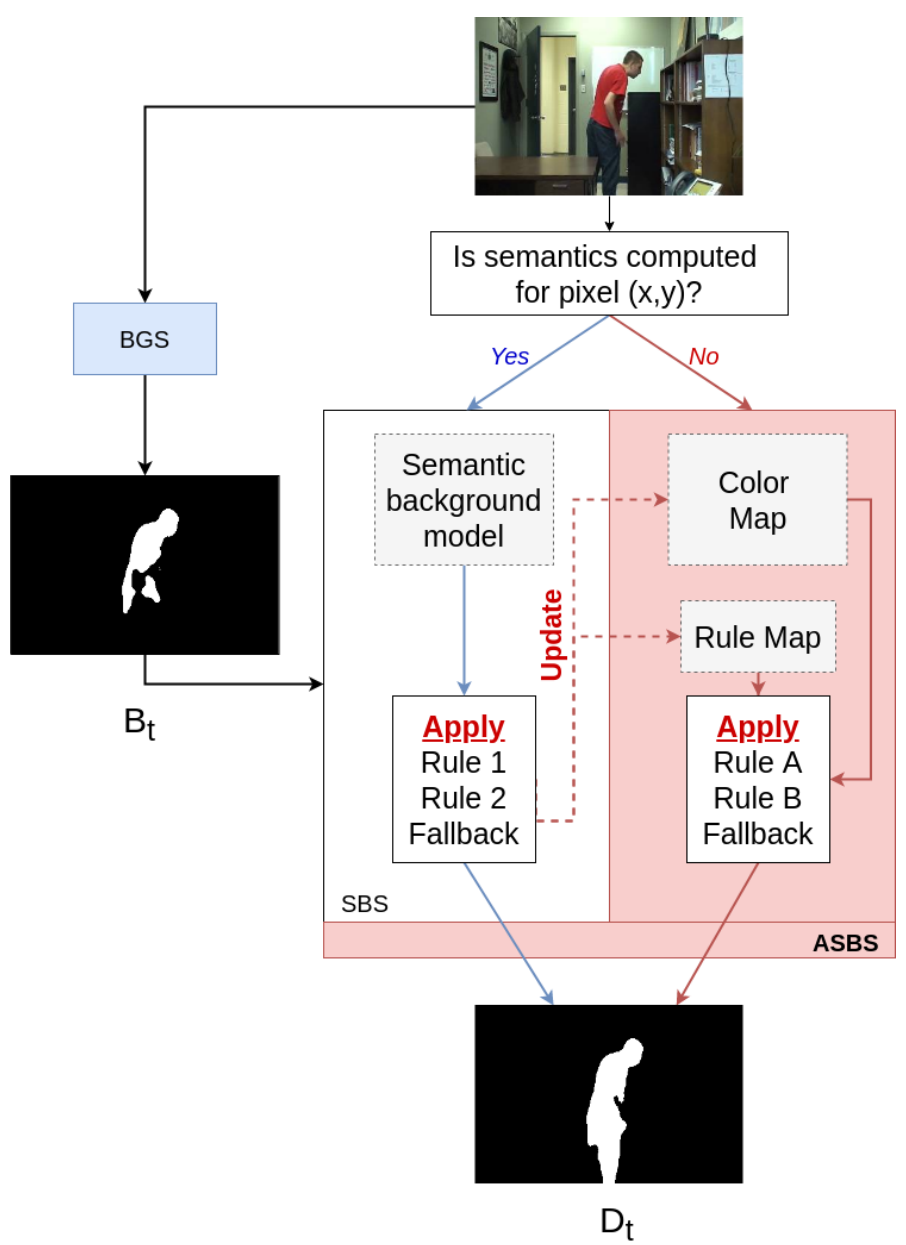
Figure 2. Schematic representation of our method named ASBS, extending SBS [30], capable to combine the two asynchronous streams of semantics and background subtraction masks to improve the performances of BGS algorithms. When semantics is available, Asynchronous Semantic Background Subtraction (ASBS) applies Rule 1, Rule 2, or selects the fallback, and it updates the color and rule maps. Otherwise, ASBS applies Rule A, Rule B, or it selects the